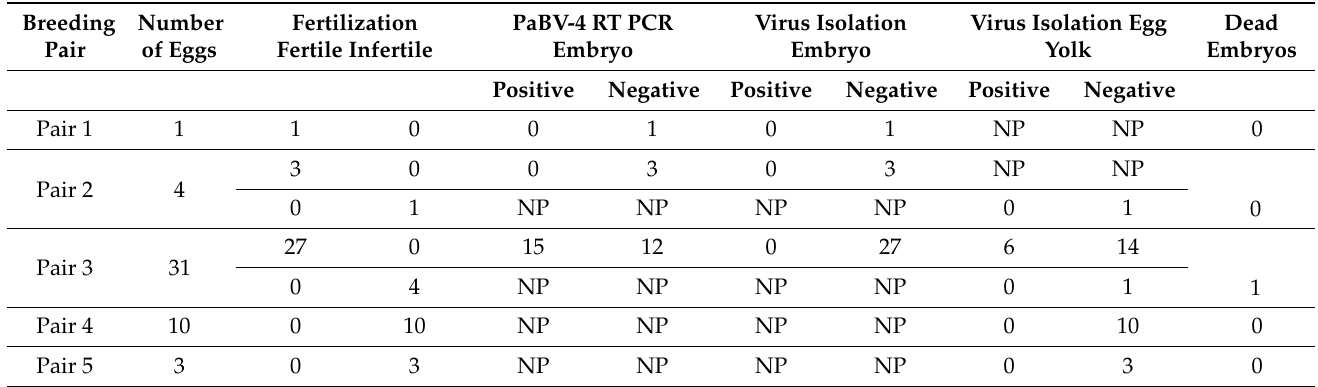
Table 3. Adult infected cockatiels: vertical transmission. Not all embryos were examined in all tests due to technical reasons. NP: not performed.